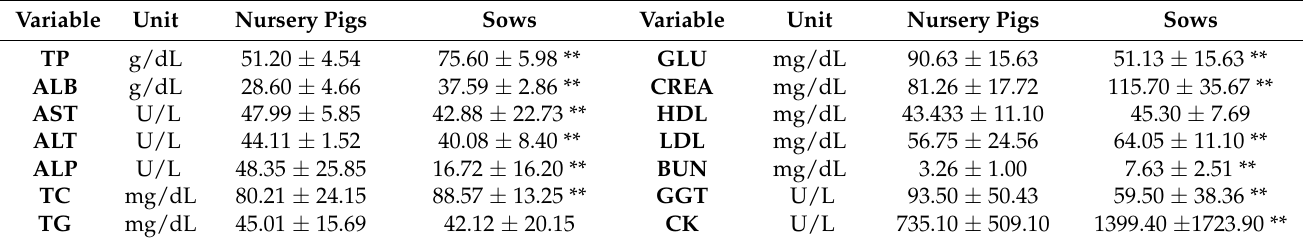
Table 2. Comparison of biochemical parameters between nursery pigs and sows.